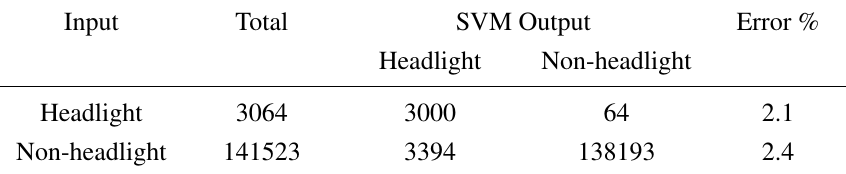
Table 6. Error analysis of the single object classification achieved by the SVM classifier.